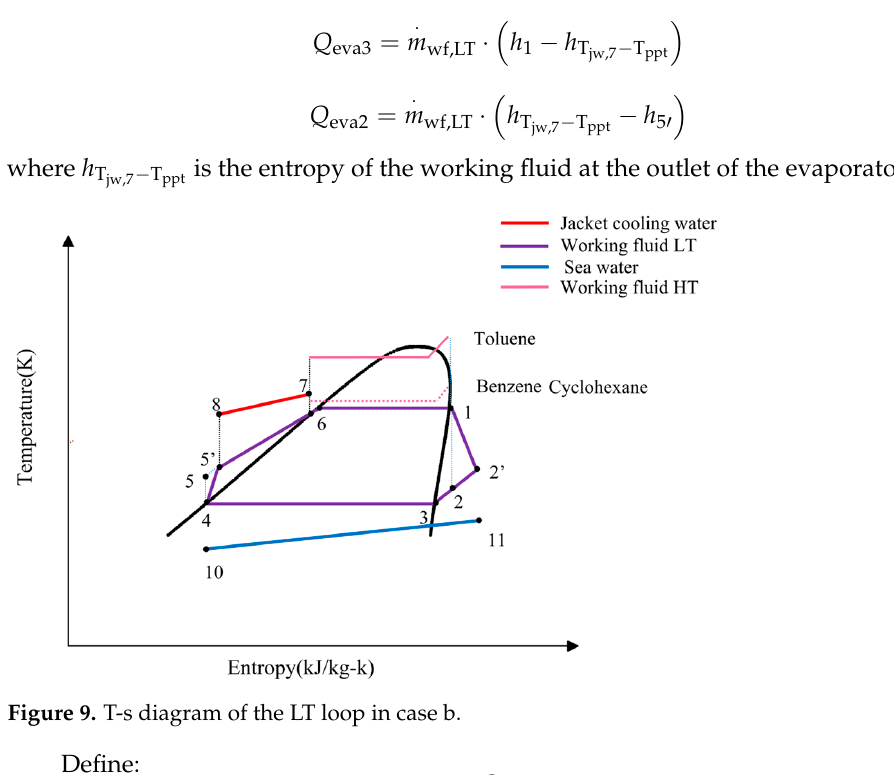
Figure 8. Flow chart of the eva,LT